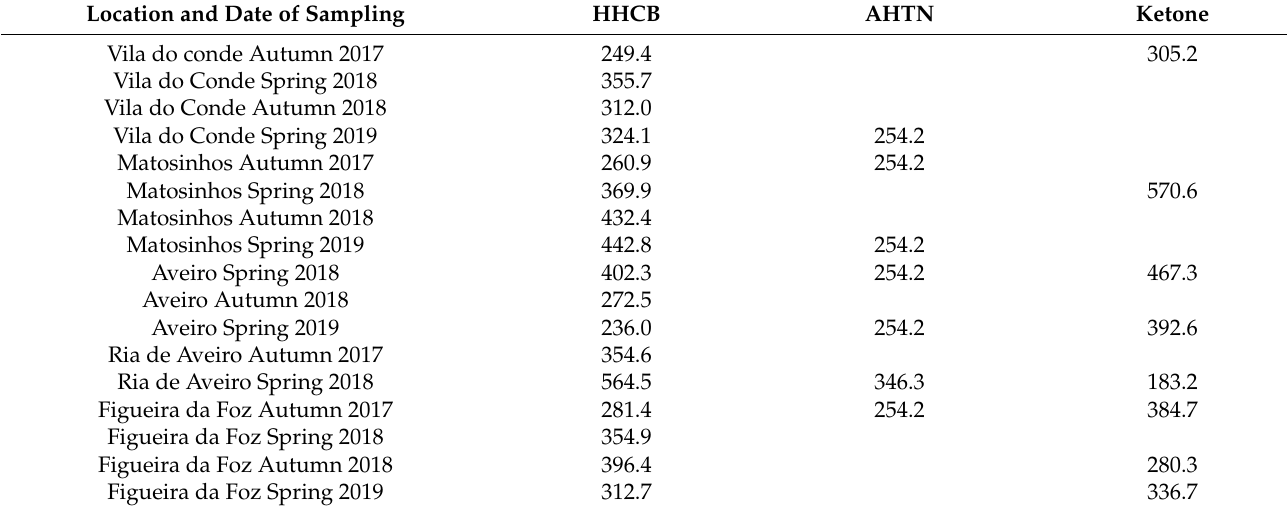
Figueira da Foz Autumn 2017 Figueira da Foz Spring 2018 354.9 Figueira da Foz Autumn 2018 396.4 280.3 Figueira da Foz Spring 2019